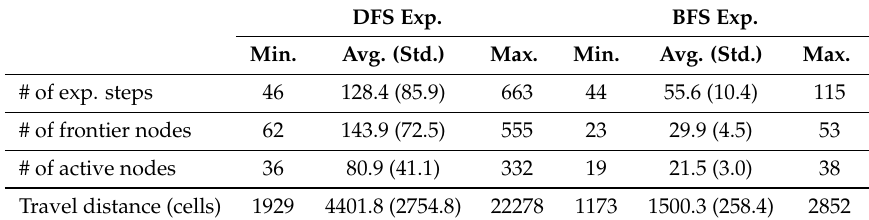
Table 3. Simulation results for 4 m LRF in Figure 6.